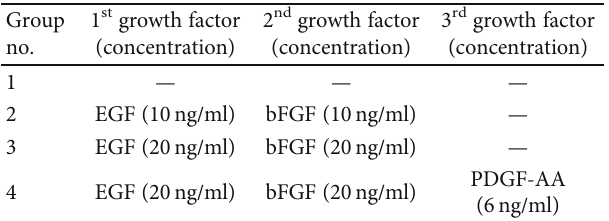
Figure 1: Generation, cultivation, characterization and proliferation of NPCs in vitro . (a) Embryo of a GFP-expressing Wistar rat before schematic dissection of the cortical hemispheres [56]. (b) Phase contrast microscopy of a 2-day old NPC monolayer culture. (c-f) Colocalization of GFP + NPCs (green) with markers for intact nuclei (DAPI, blue) and stem cells (Nestin, red). (g) Phase contrast microscopy of an NPC monolayer culture after 7 days of cultivation. (h) GFP + NPCs quanti fi ed after 7 days of incubation with the di ff erent growth factor concentrations/combinations in groups 1-4. Table 1: Di ff erent concentrations/combinations of growth factors used in vitro